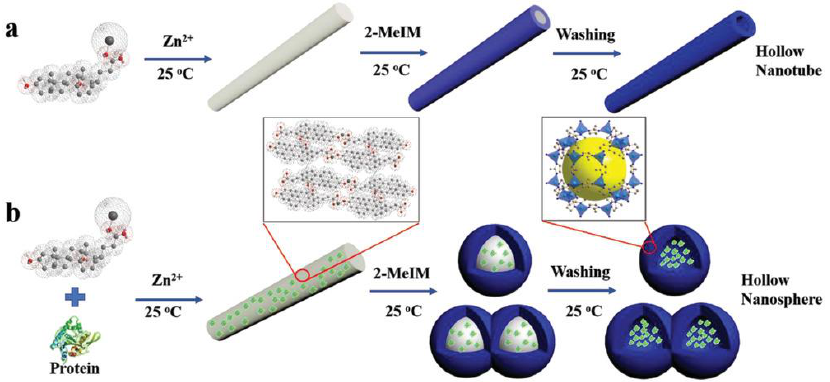
Figure 3. Schematic diagram of the formation process of hollow – MOF tubes and spheres. Reprinted with permission from Ref. [33]. Copyright 2019, WILEY-VCH Verlag GmbH.